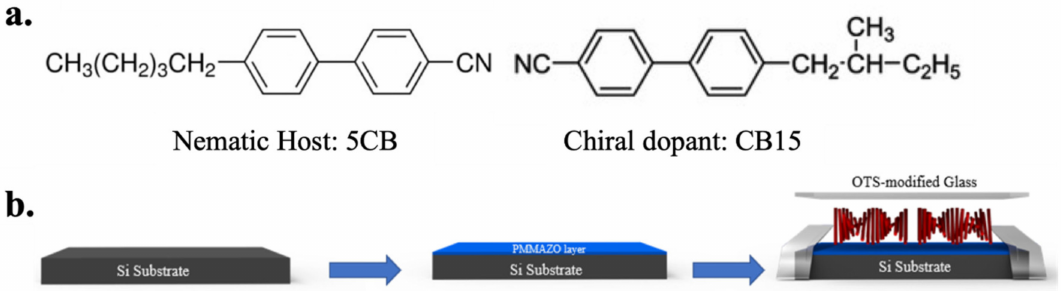
Figure 1. ( a ) Chemical structures of chiral nematic liquid crystals. ( b ) Illustration of cell preparation process. PMMAZO brushes are coated on the cleaned wafer and grafted to the substrate through thermal annealing. Glass slides are modified by octadecyl-trichlorosilane (OTS). Two surface-modified substrates are sandwiched together to form the liquid crystal (LC) cell. The separation distance is controlled by Mylar film as spacers. The injection process needed to be conducted on the heating stage above the isotropic transition temperature of cholesteric liquid crystals (CLCs).